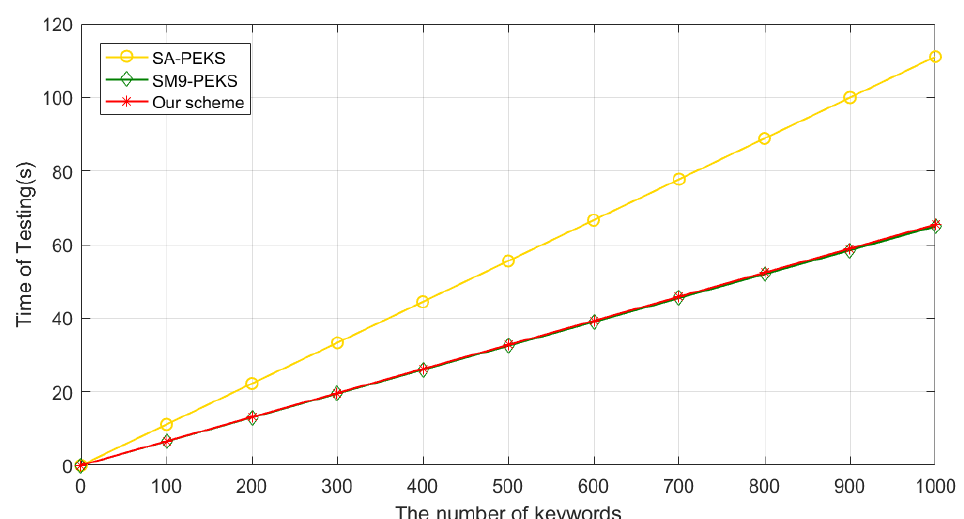
Figure 6. Computation cost of testing.